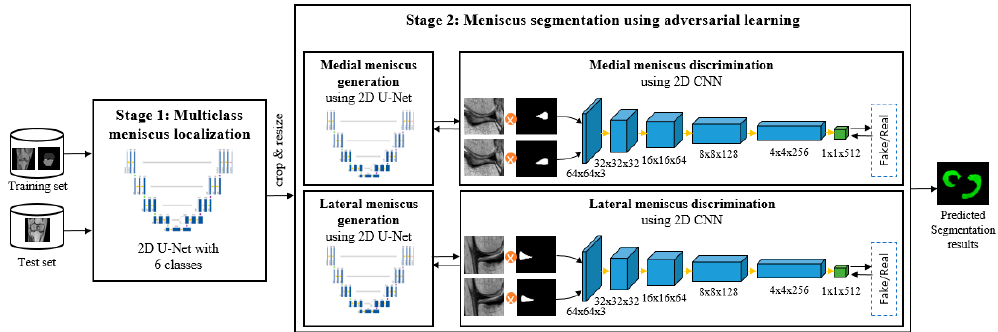
Figure 2. Pipeline of the proposed method.